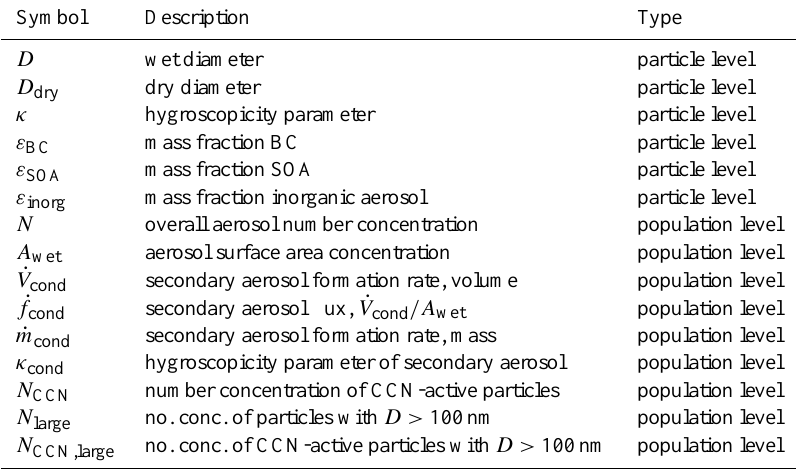
Table 5. Candidate variables included in the regression